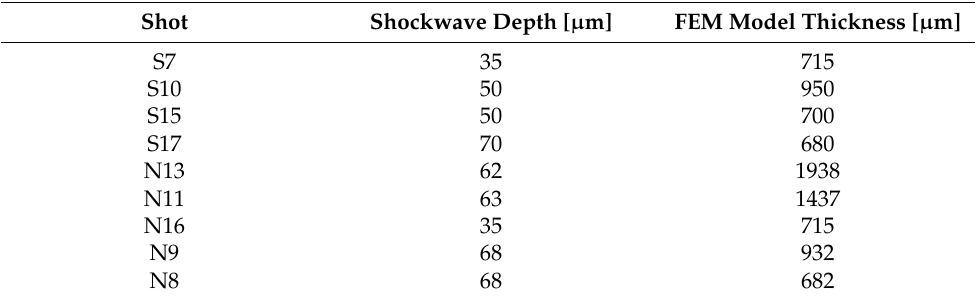
Figure 6. Representation of the pressure plots of the shot S7 used to find the shockwave front at the end deposition time. The figure on the right is the magnification of the left one. Table 3. Helios shot results concerning the shockwave depth reached at the end deposition time and the resulting target specimen after the deduction of the removed